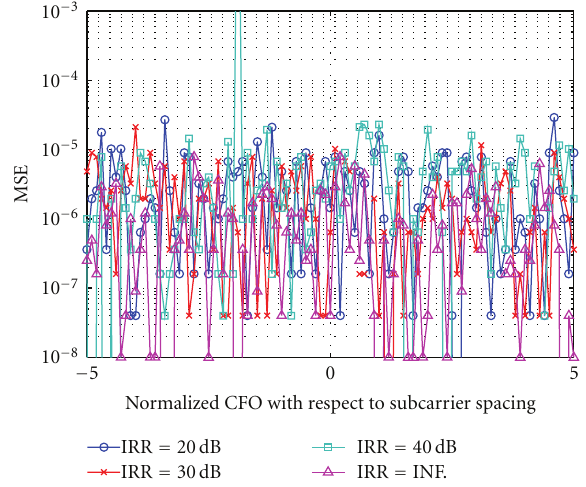
Figure 8: MSE of sparse pilot-based CFO estimator versus normal- ized CFO for 64-QAM OFDM syste; 39-tap veh. A channel model; ensemble average of 500 independent channel